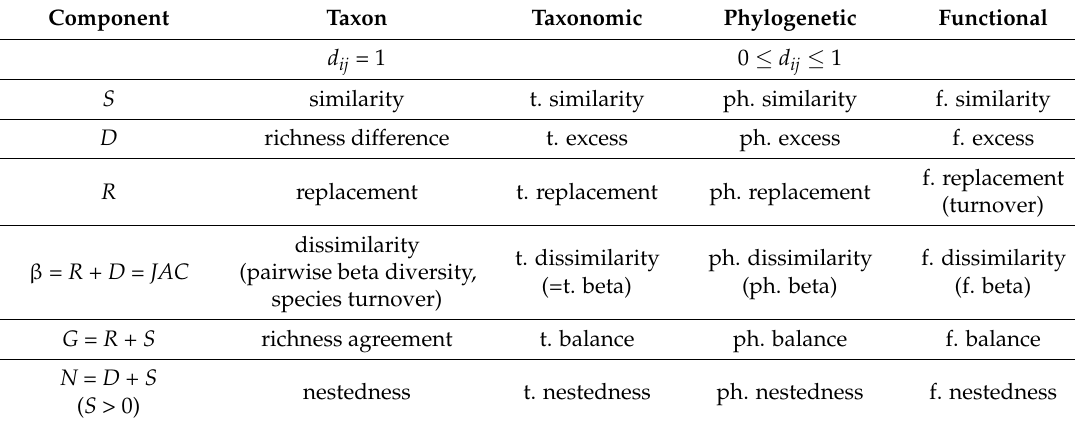
Table 1. Components of the SDR simplex for traditional taxon-based presence–absence data and their modification according to taxonomic, phylogenetic and functional distinctness of